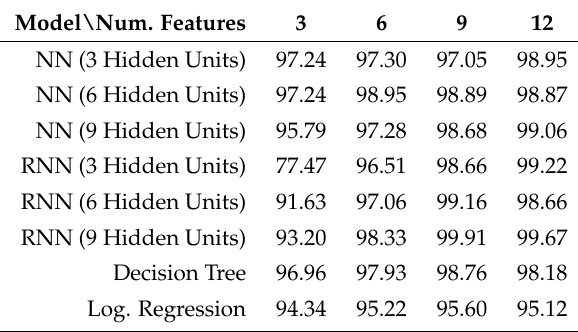
Table 8. Accuracies of quantized models in